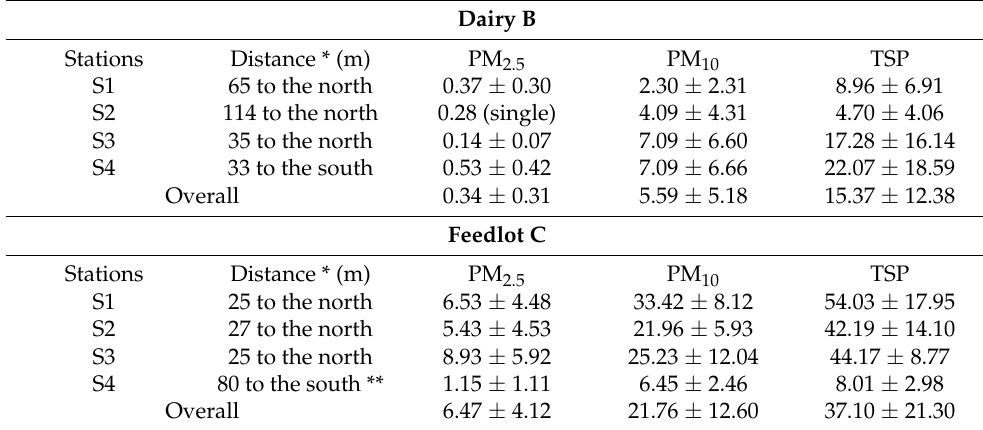
Table 3. Mean EF (kg 1000-hd − 1 d − 1 ) in each sampling stations of Dairy B and Feedlot